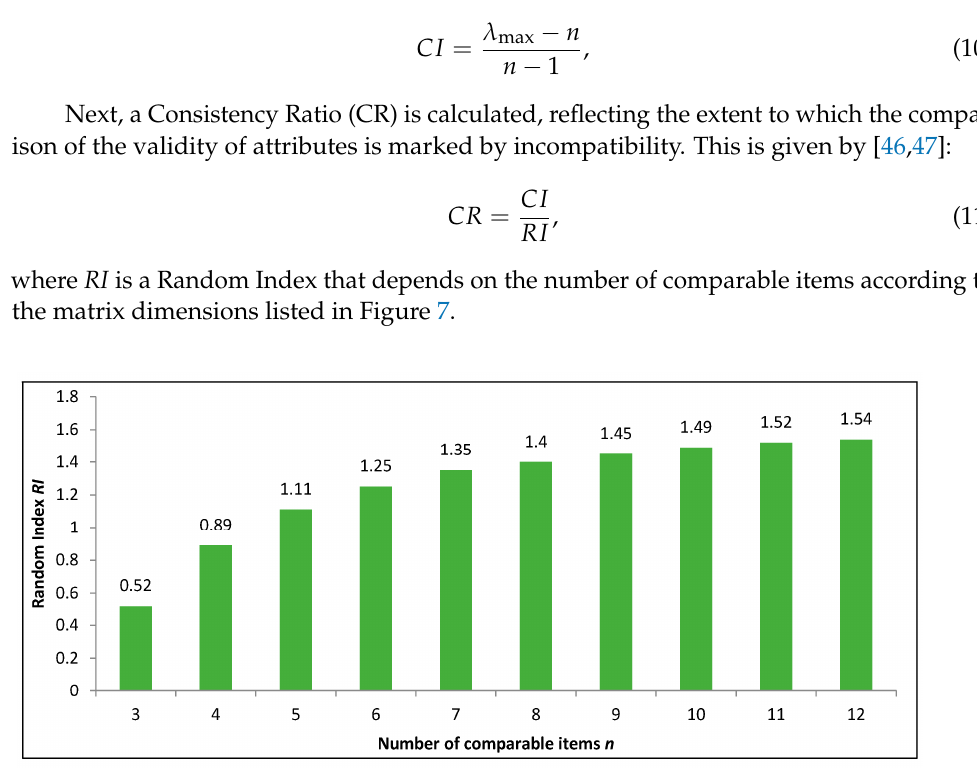
Figure 7. RI values corresponding to matrix dimensions (after Saaty [46,47]).